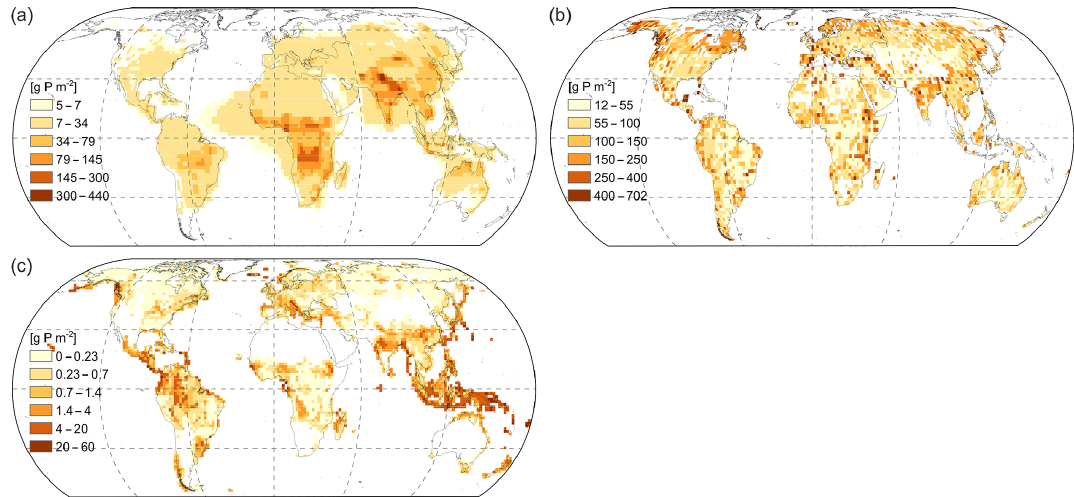
Figure 3. Different sources of geogenic P. (a) Cumulative atmospheric P deposition for 2006–2099 according to Wang et al. (2017). (b) Total inorganic labile P and organic P in the soil up to a depth of 0.5m according to Yang et al. (2014a). (c) Cumulative weathering P release for the 21st century (2006–2099) based on Hartmann et al. (2014), accounting for weathering rate changes related to temperature increase (Goll et al., 2014). © ESRI.